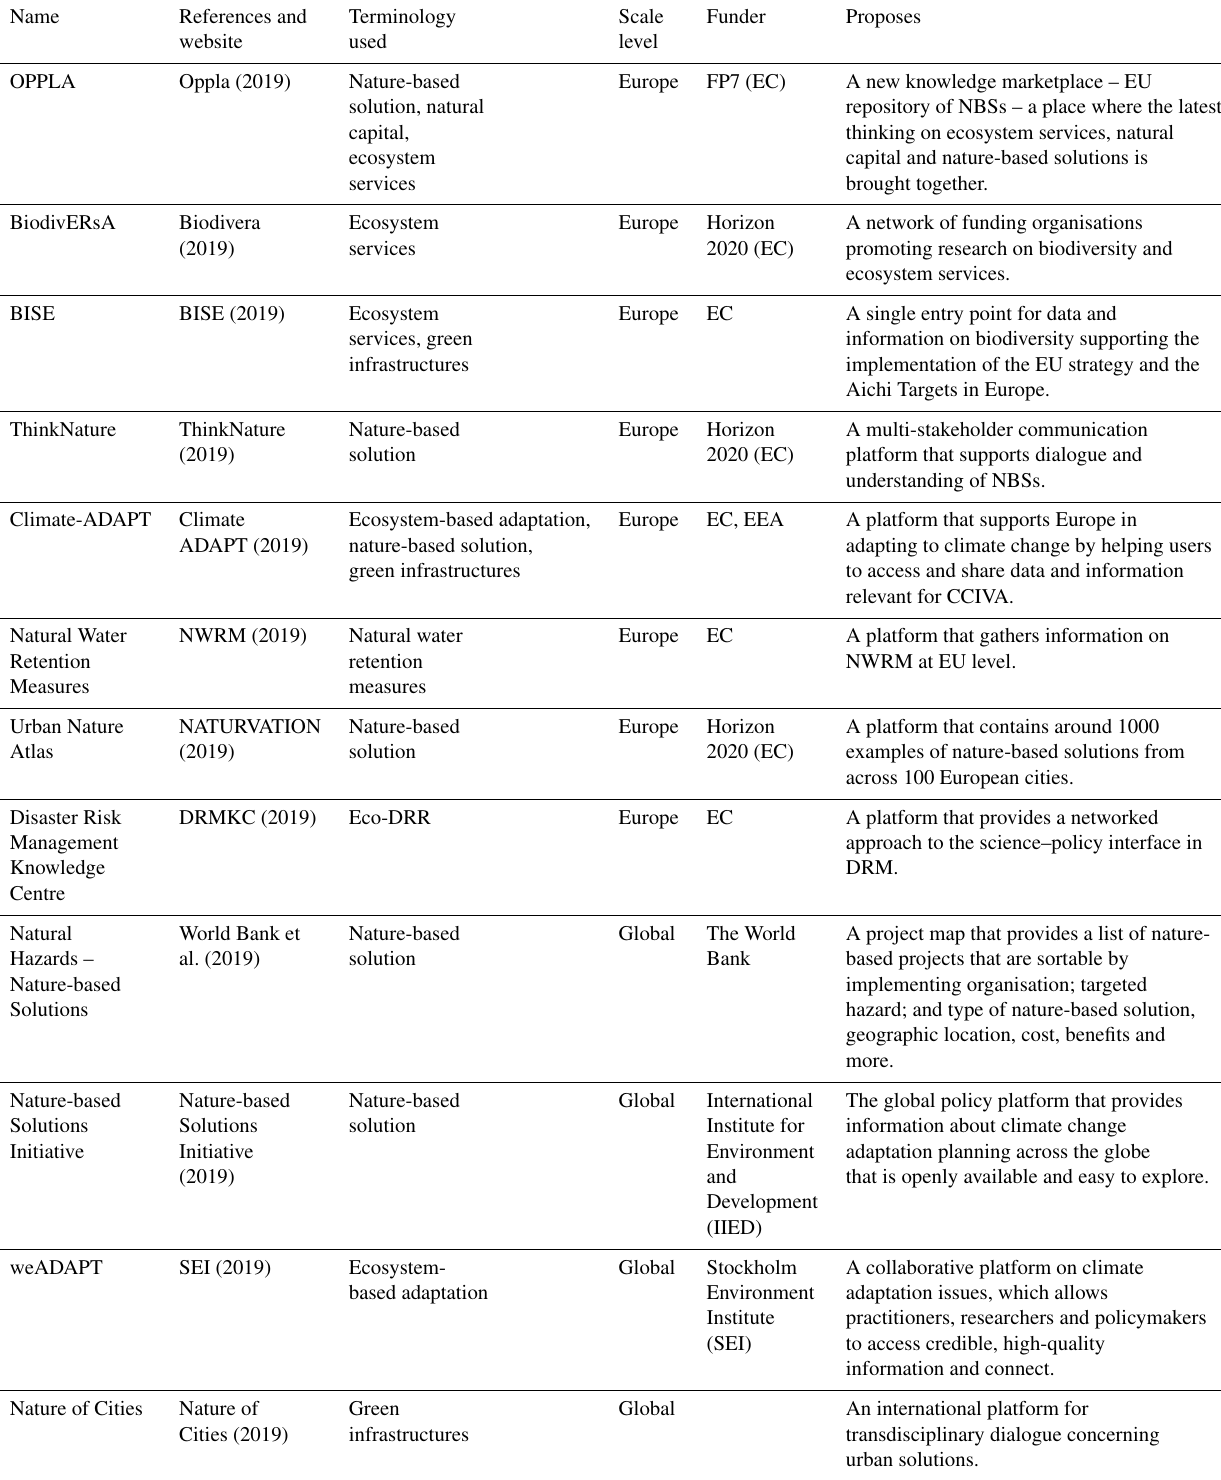
Table 6. An overview of web portals, networks and initiatives that address nature-based